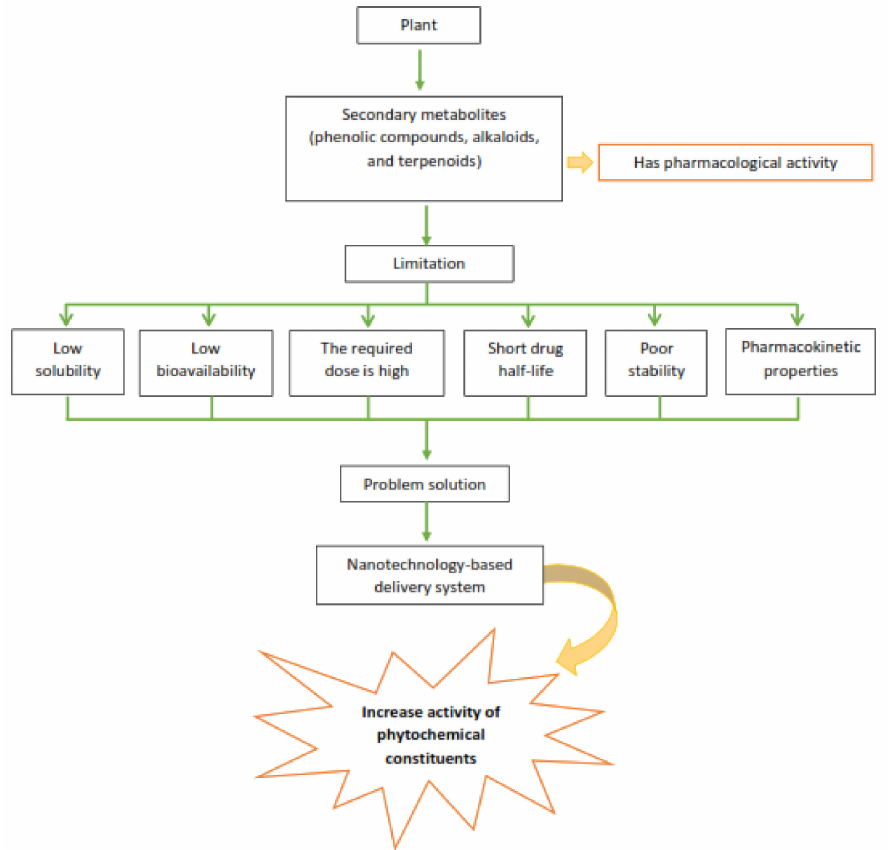
Figure 1. Schematic showing the deficiencies of the phytochemicals that limit their clinical application.